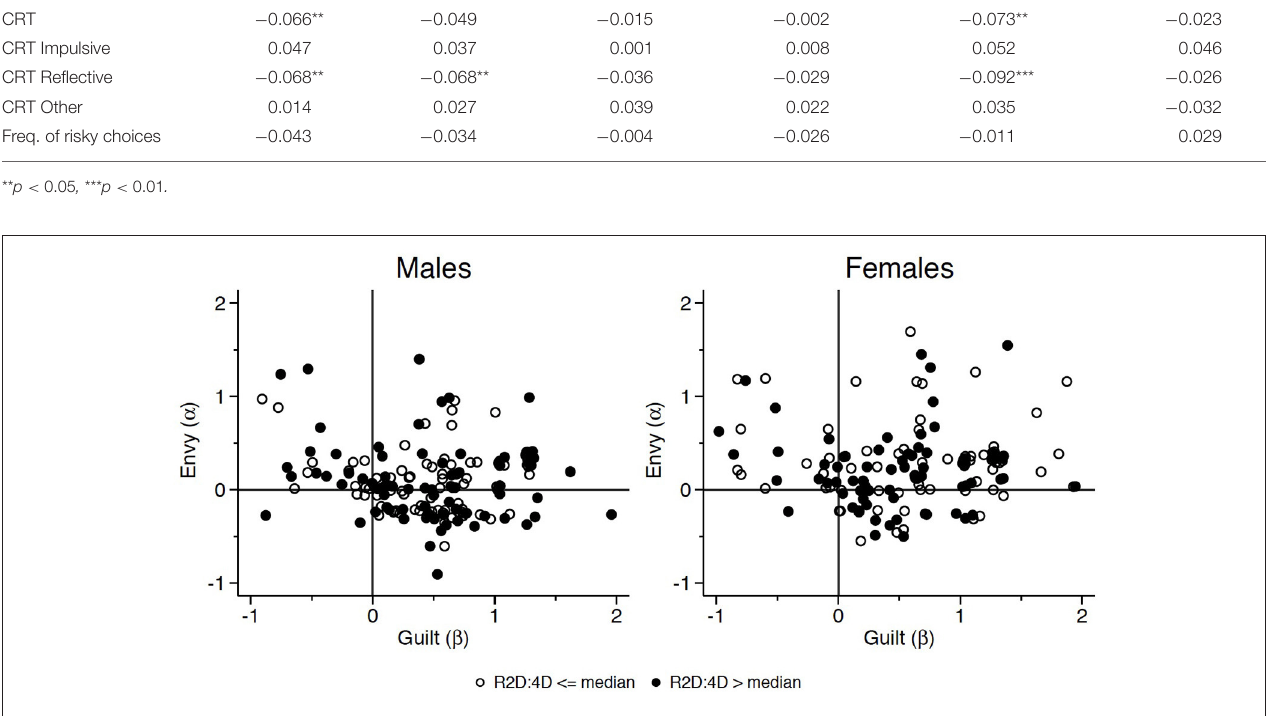
FIGURE 4 | Social preferences: individual